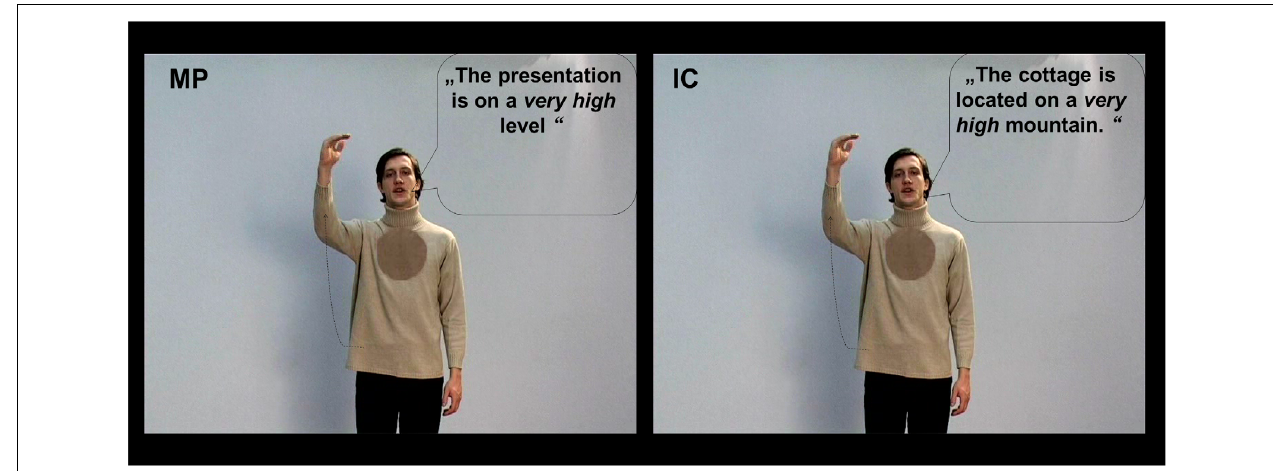
FIGURE 1 | Picture illustration for the metaphoric (MP) and iconic (IC) gesture conditions in the co-speech condition (G). Same videos were also presented with two additional modality conditions: gestures with foreign Russian (R) sentences, German sentences without any gestures (N). For illustrative purposes the spoken German sentences were translated into English. For this figure all spoken sentences are written into speech bubbles.